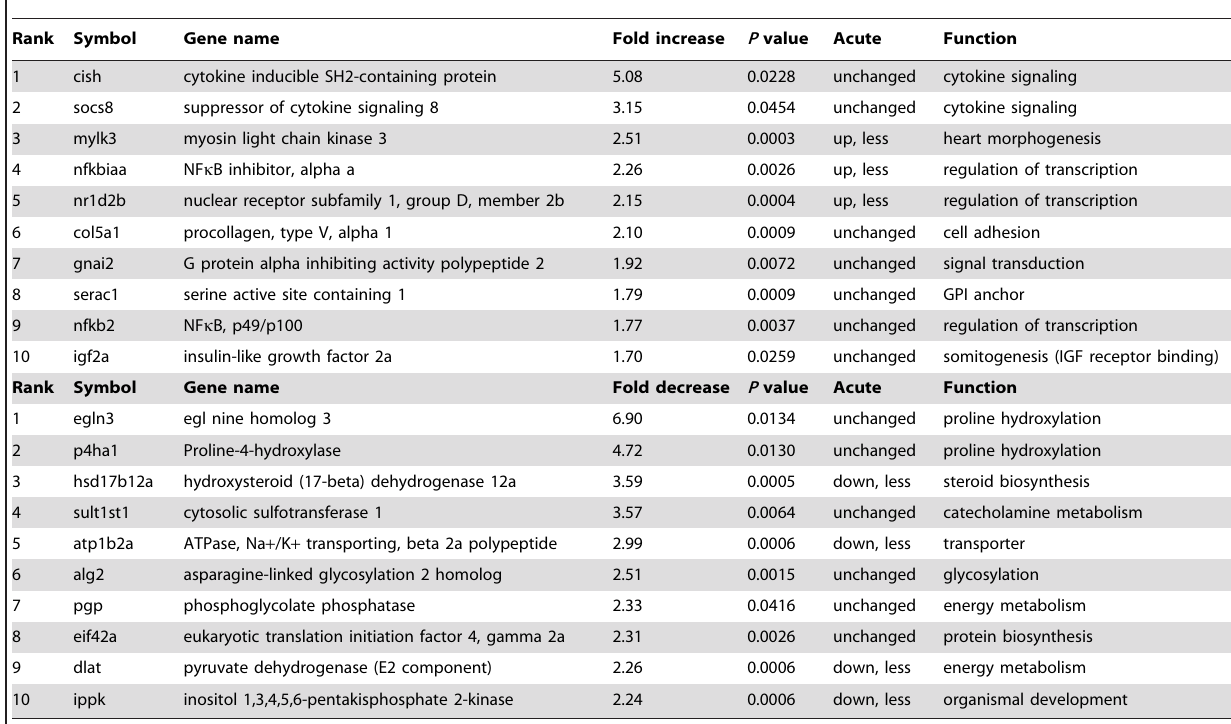
Table 1. Genes increased or decreased as part of the long-term response to radiation.